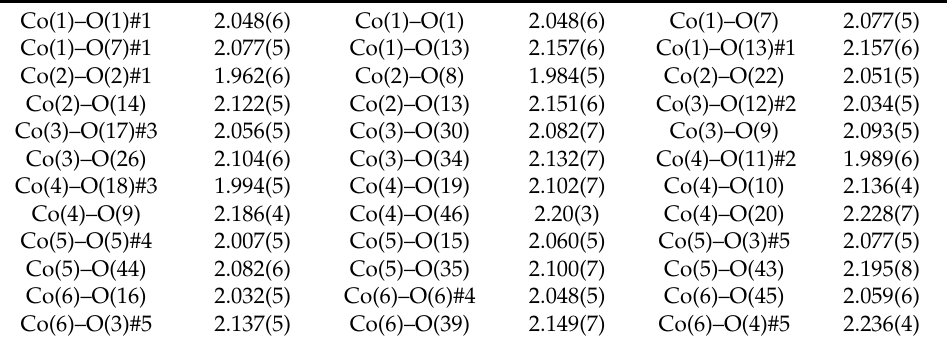
Table 2. Selected bond distances of MOF 1 involving the Co